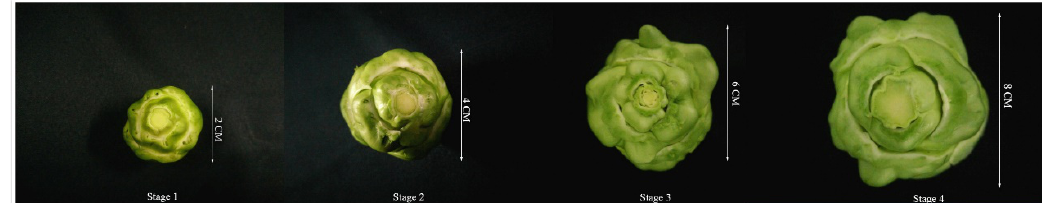
Figure 1. Growth state of stem mustard in four different development stages.